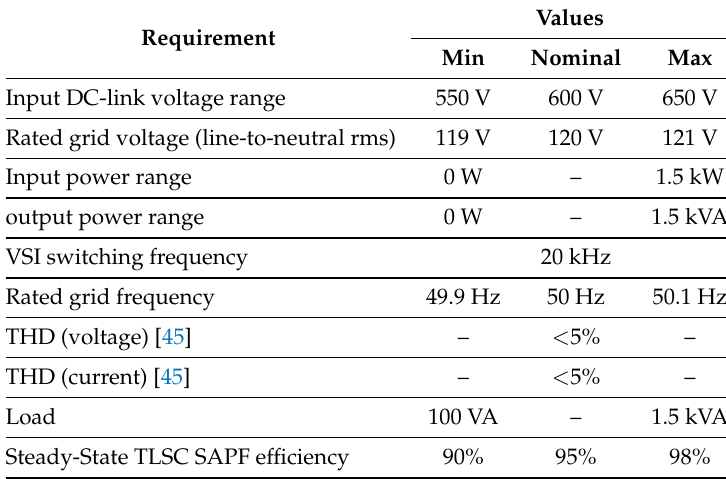
Table 1. TLSC SAPF operating requirements. VSI, Voltage Source Inverter.